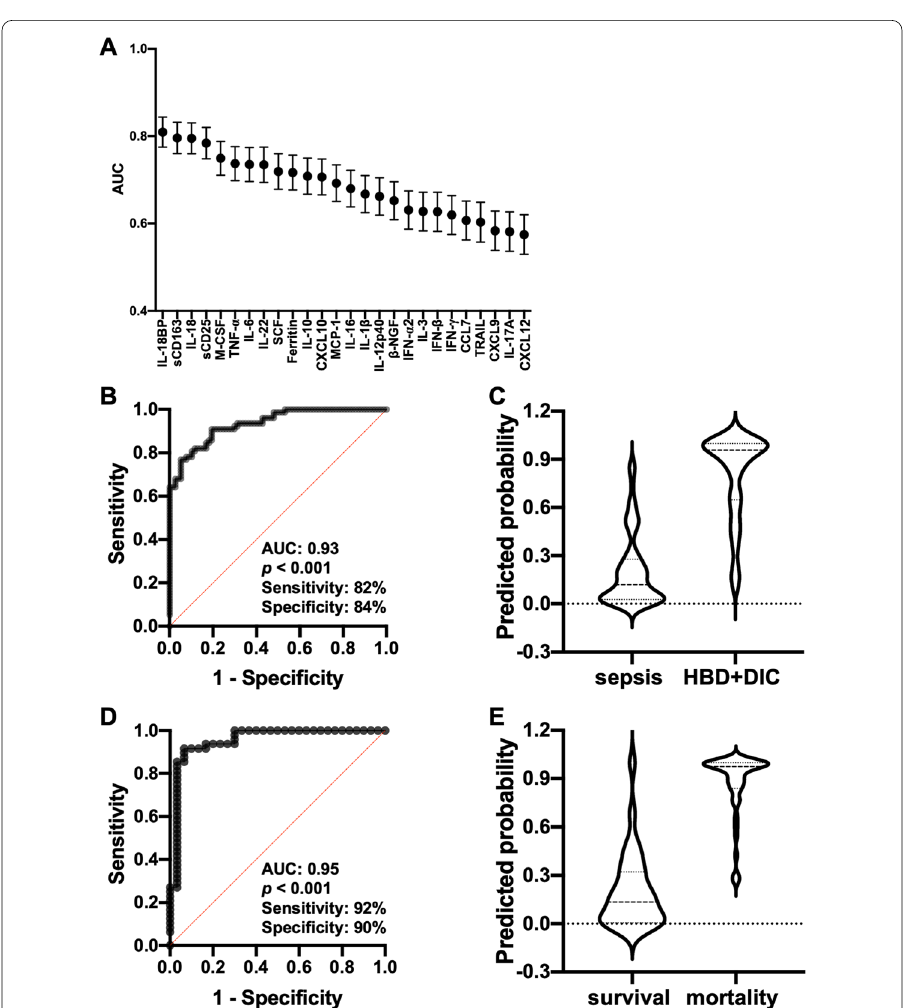
Fig. 4 Performance of selected biomarkers to predict the presence of HBD DIC and 90-day mortality + during sepsis. A AUC for each of the 26 biomarkers to predict the presence of HBD DIC in patients with + sepsis, organized from highest to lowest. B ROC curve representing the model using 26 biomarkers for predicting the HBD DIC phenotype in patients with sepsis. C Violin plots showing the distribution of + predicted probabilities for the presence of HBD DIC in sepsis. The model performed well at classifying + both sepsis controls and sepsis with HBD DIC. The majority of sepsis controls had predicted probabilities of + presenting with HBD DIC less than 0.50 (median: 0.12, IQR: 0.03–0.28). By contrast, the cases had predicted + probabilities that were overwhelmingly greater than 0.50 (median: 0.96, IQR: 0.65–0.99). D ROC curve representing the model using 26 biomarkers for predicting 90-day mortality among the HBD DIC subset + of patients with sepsis. E Violin plots showing the distribution of predicted probabilities for mortality in the cases. The model performed well at distinguishing between survivors (median: 0.13, IQR: 0.01–0.32) and non-survivors (median: 0.97, IQR: 0.84–0.99) among those with HBD +